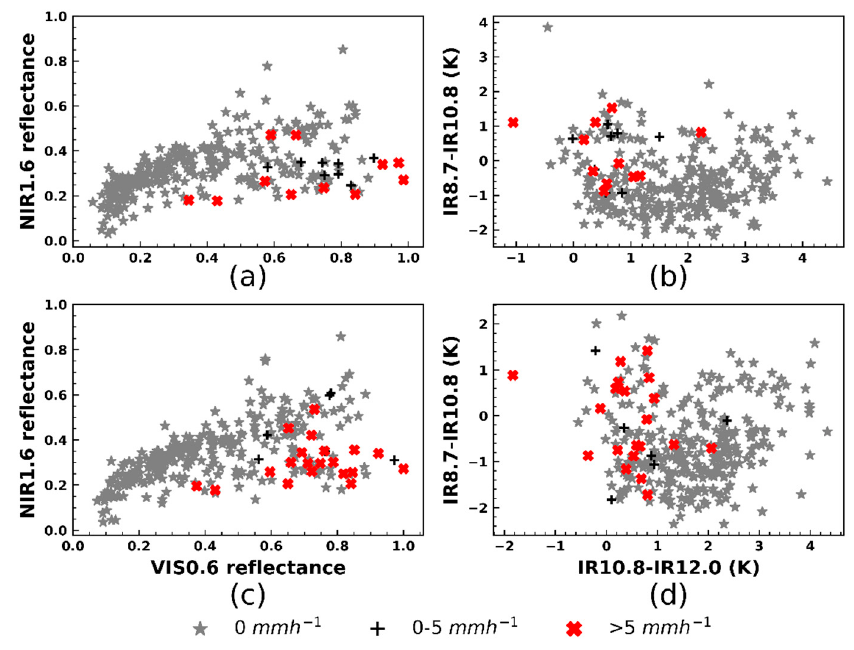
Figure 5. Day time R RG ( a , b ) and R MWL ( c , d ) as a function of VIS 0.6 µm versus NIR 1.6 µm ( a , c ), and ∆ T IR10.8-IR12.0 versus ∆ T IR8.7-IR10.8 ( b , d ) for Kericho.